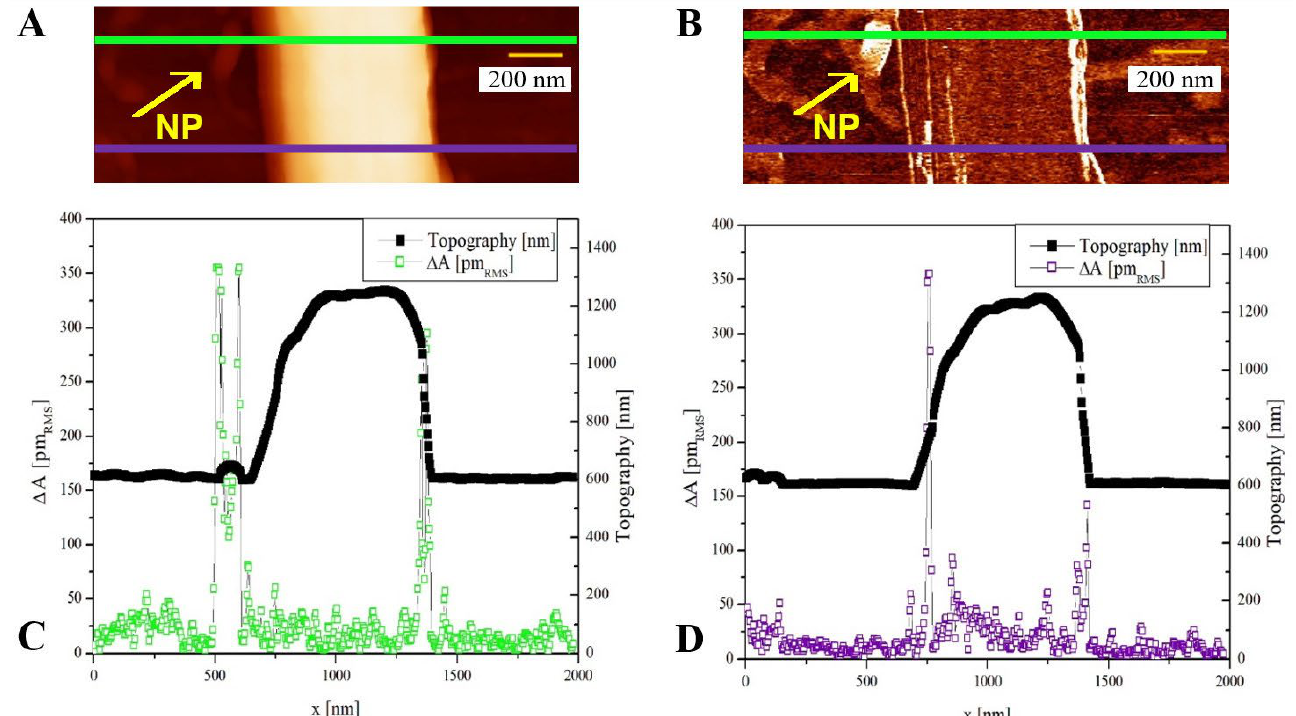
Figure 4. ( A ) Topography and ( B ) PFM amplitude scan of an electrospun PVDF/BaTiO 3 composite nanofiber as deposited on the rotating electrospinning aluminum substrate, on which a BaTiO 3 nanoparticle is also visible, indicated by the arrow. ( C ) Line profiles corresponding to the green line in ( A , B ), crossing the nanoparticle. ( D ) Line profiles corresponding to the purple line in ( A , B ), not crossing the nanoparticle. The applied potential V ac was 1 V RMS here; therefore, the Δ A value corresponds to the piezoelectric coefficient.